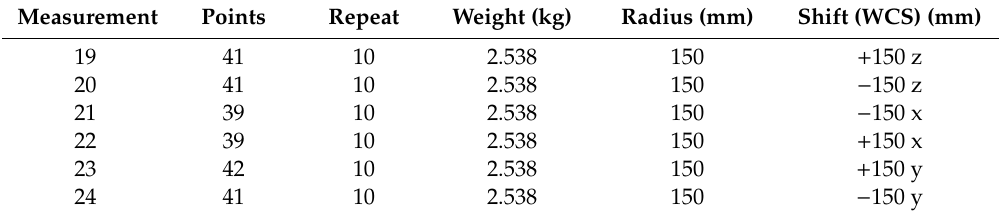
Table 8. Parameters for measurements of the influence of the measured target position. Measurement